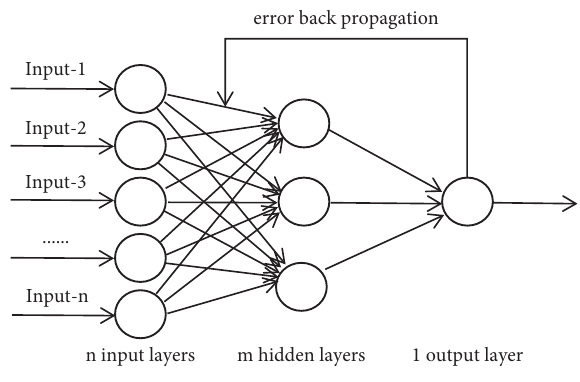
Figure 2: BP neural network structure.